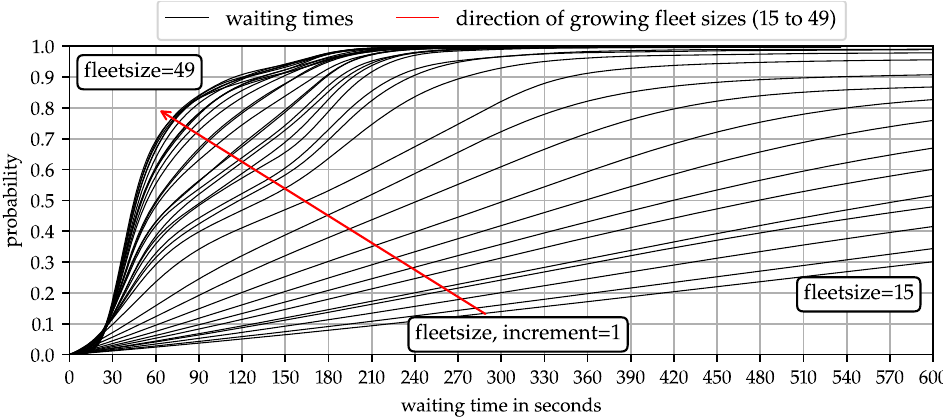
Figure 4. CDF of average waiting times for increasing